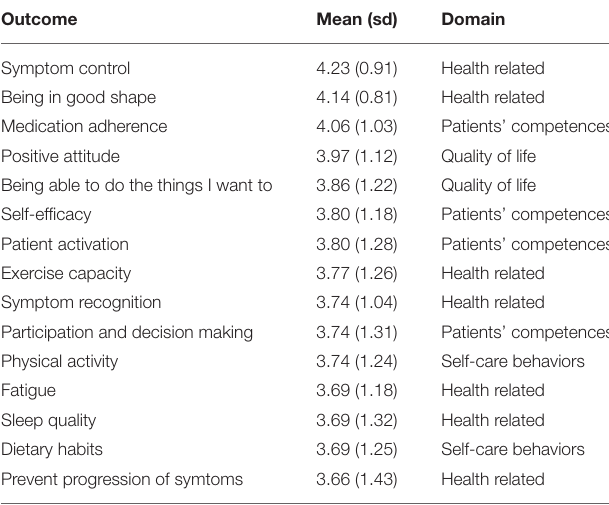
TABLE 3 | Top-15 outcome mean